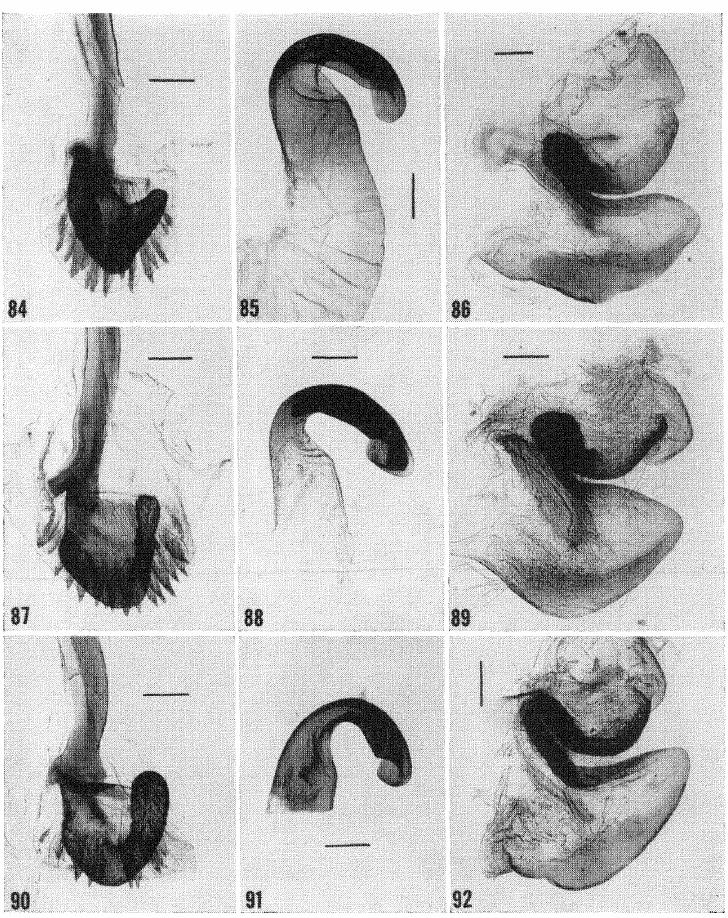
Figs. 84-92. 84-86. (13 ANSP). Hemiblabera pabulator. Paratype. Nas- sau, Bahamas. 87-89. (16 MCZ). H. pabulator. (from specimen shown in Fig. 20). 90-92. (24 ANSP). Hemiblabera granulator. (from specimen shown in Fig. 17). (scale-- 0.3